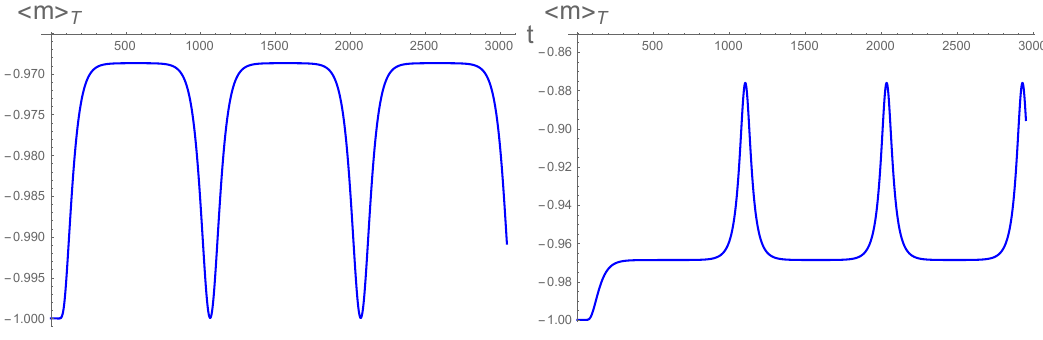
Figure 10 . Left: for (cid:12) = 142 : 4117050 > (cid:12) c , we obtain a TMS that beats downward. Right: for